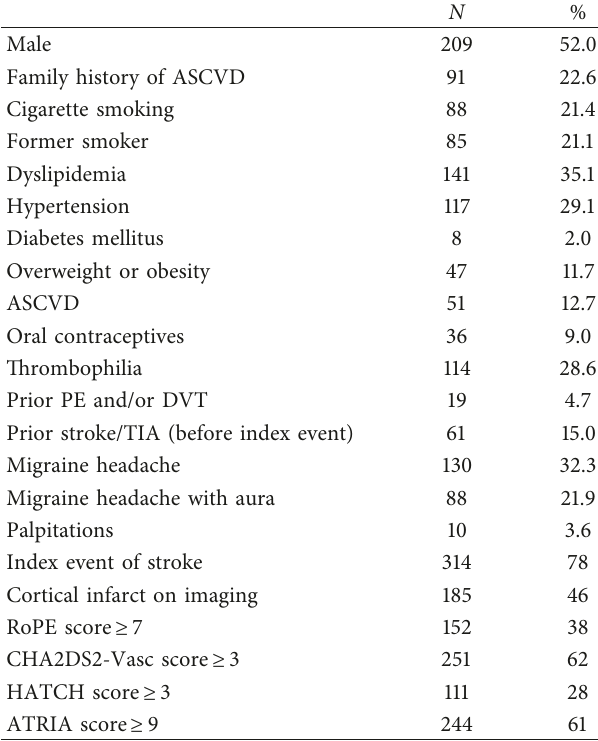
Table 1: Baseline clinical characteristics of patients before PFO closure ( n �